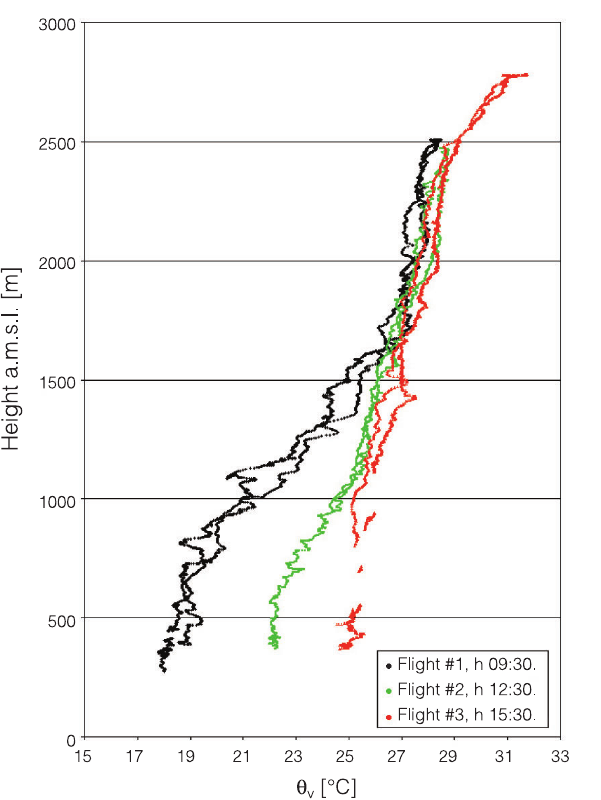
Fig. 7. Profi les of virtual potential temperature q during subsequent fl ights performed in the Adige Valley over Besenello, 1.10.1999 at times reported on the fi